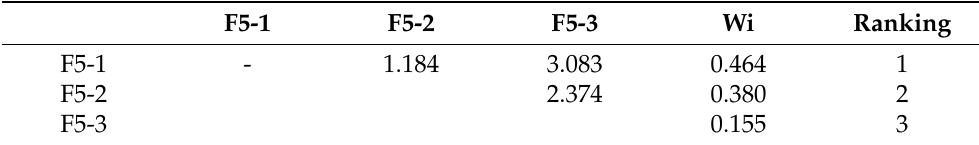
Table 12. Ranking of secondary factors in “green product distribution”.